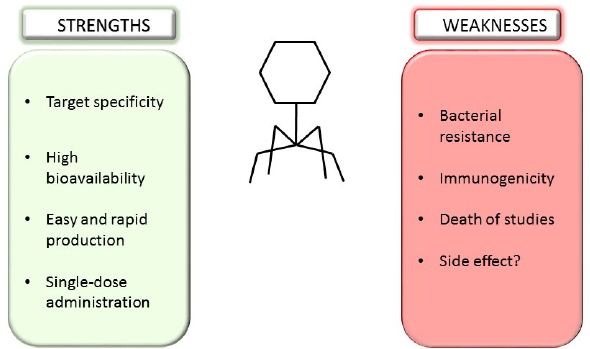
Figure 4. Strengths and weaknesses of phage therapy.